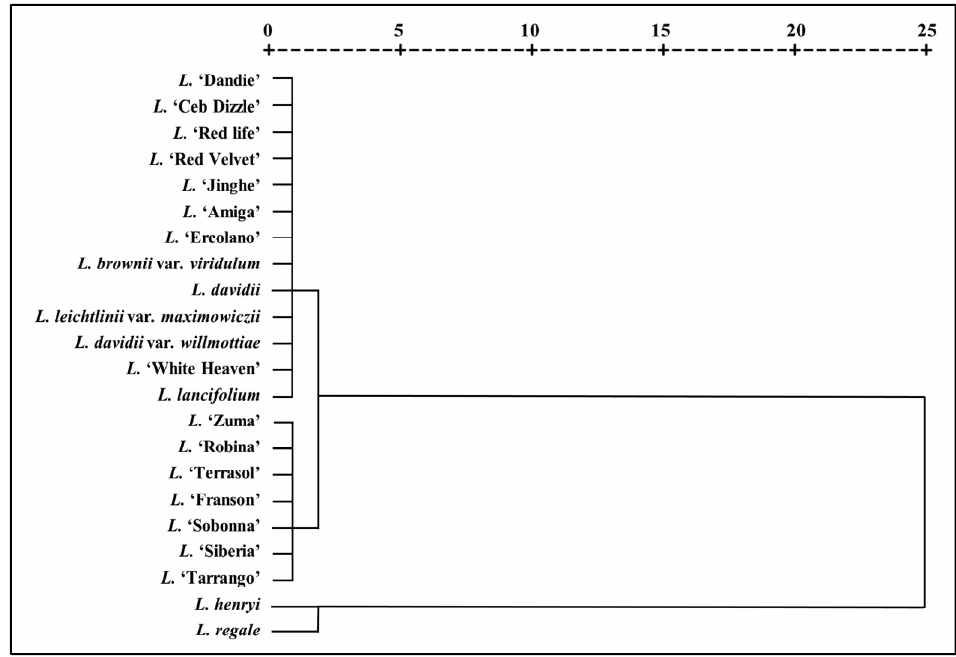
Figure 1. Dendrogram plot of hierarchical cluster analysis of 22 Lilium species based on the TPC, TFC and antioxidant